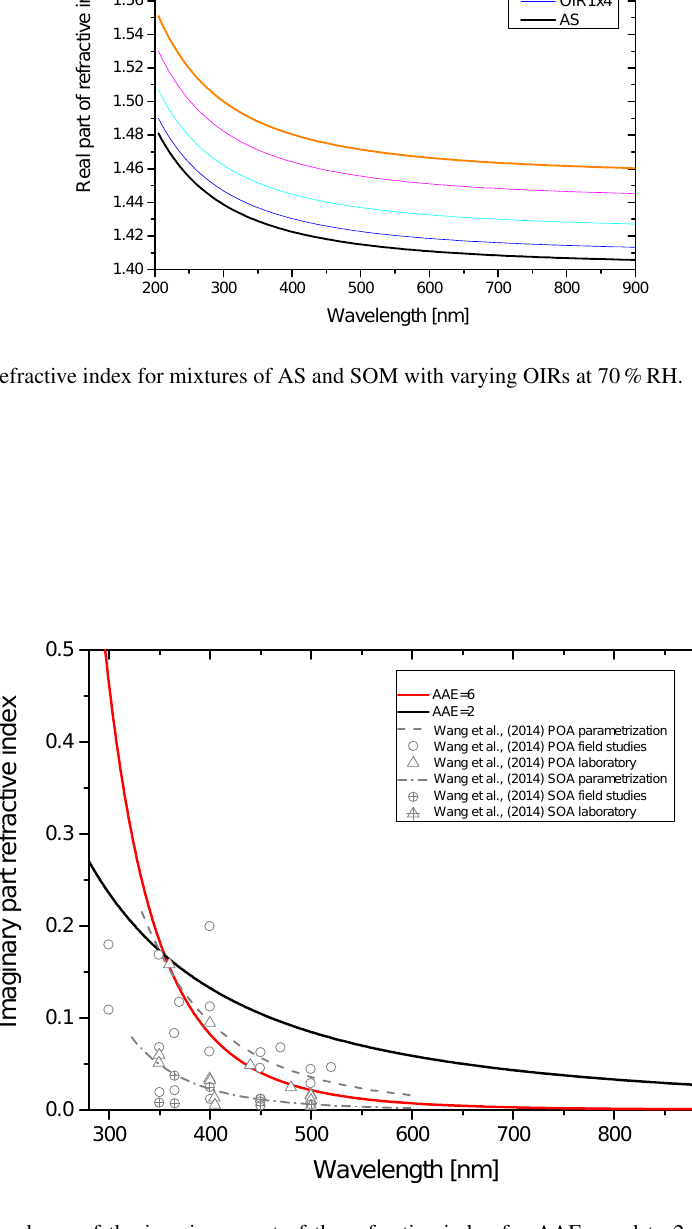
Figure B3. Wavelength dependence of the imaginary part of the refractive index for AAE equal to 2 and 6 (solid black and red lines, respectively; k = 0 . 168 for λ = 355nm). For comparison the parametrizations of Wang et al. (2014) for brown primary organic aerosol (POA, dashed gray line) and brown secondary organic aerosol (SOA, dashed-dotted gray line) are plotted as well as the data from laboratory and field studies collected by Wang et al.